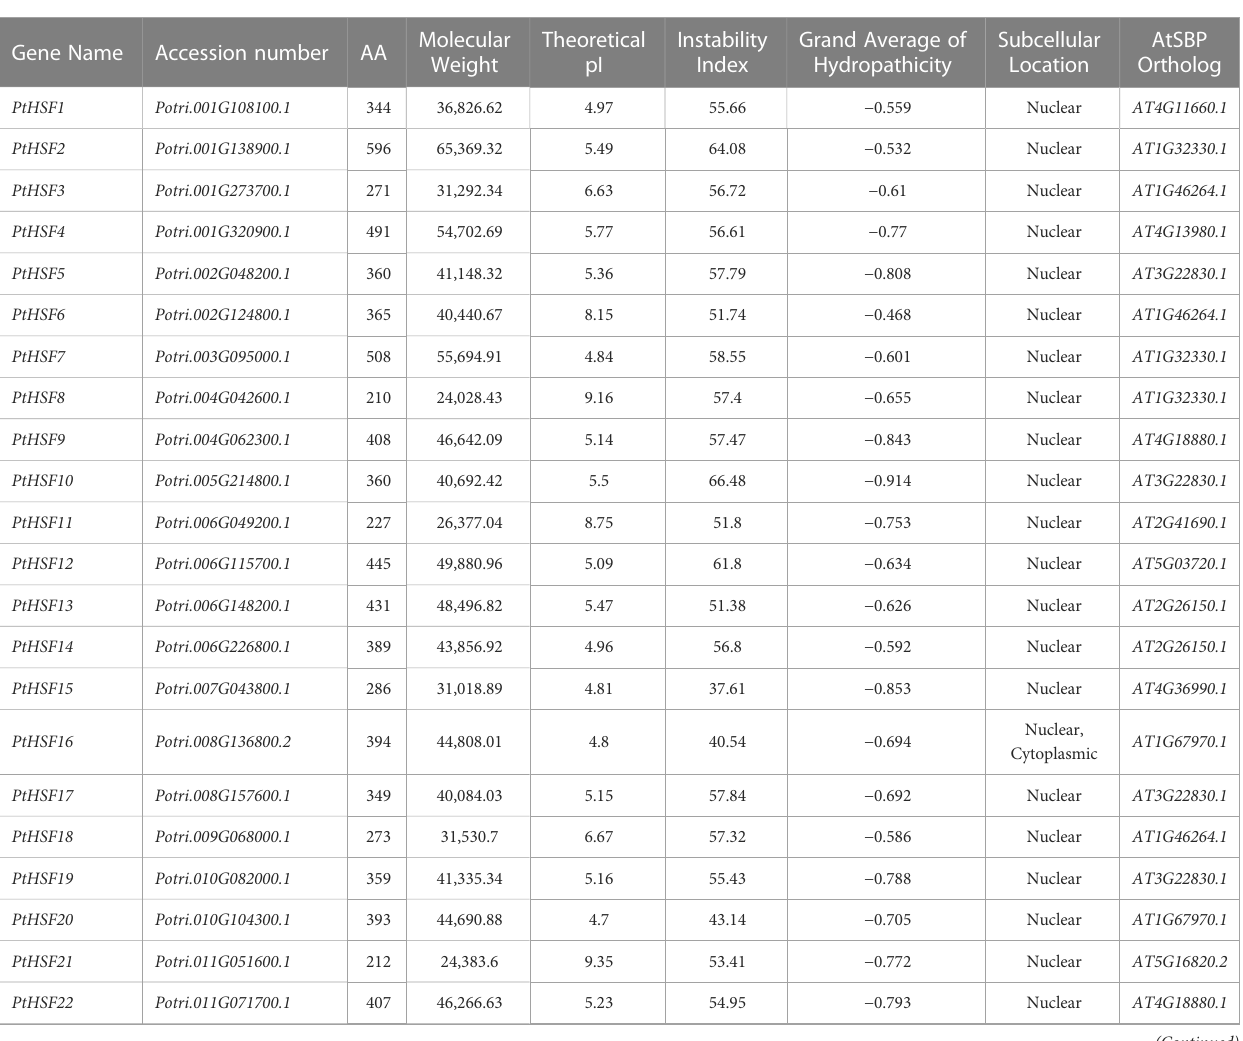
TABLE 1 Analysis of PtHSF